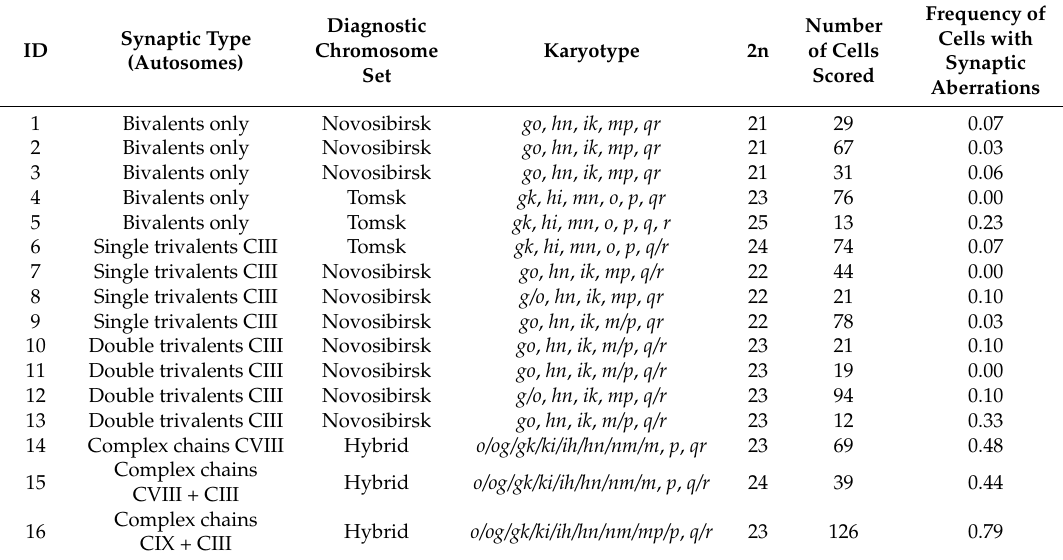
Table 1. The frequency of synaptic